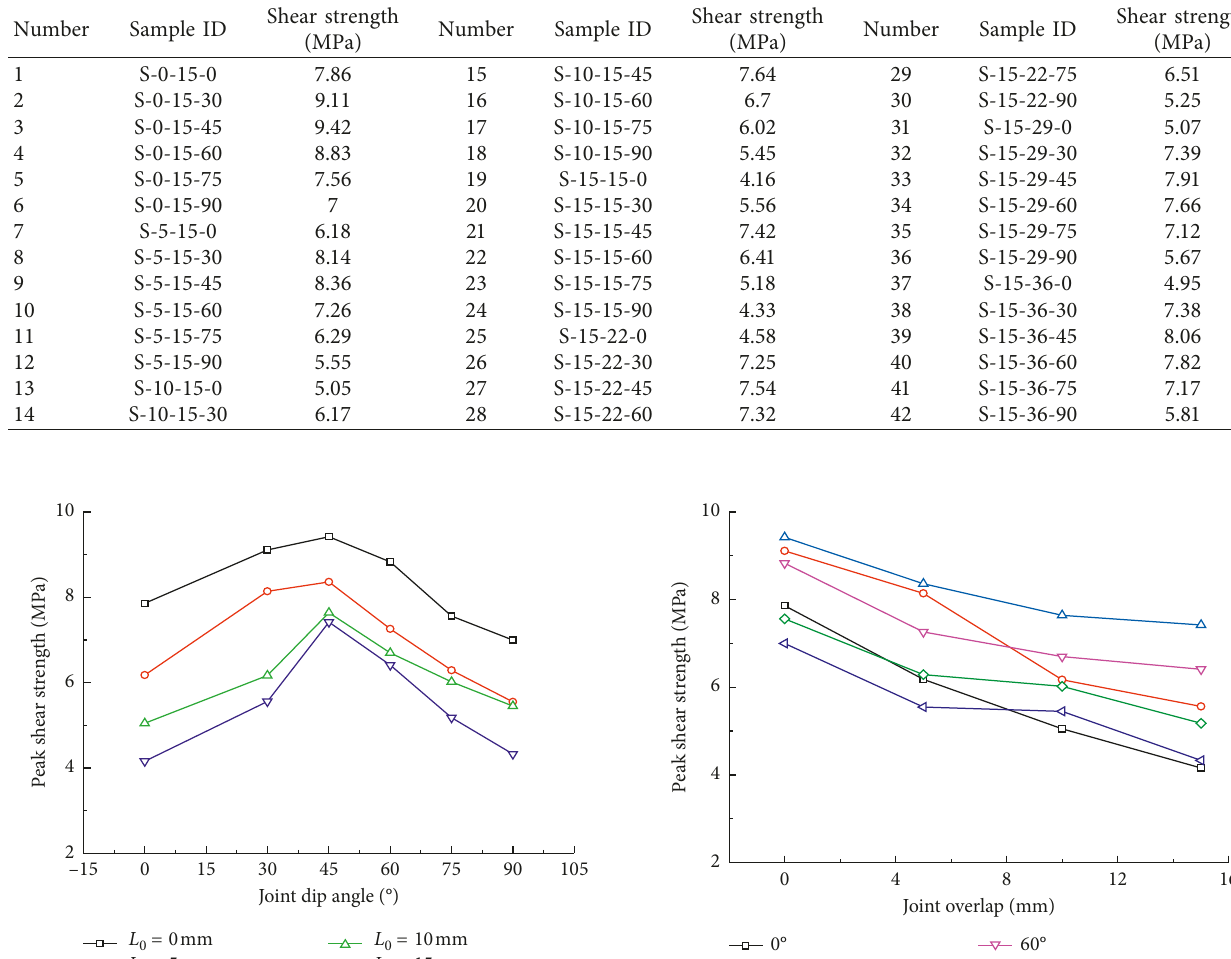
Table 3: The shear strength of joint